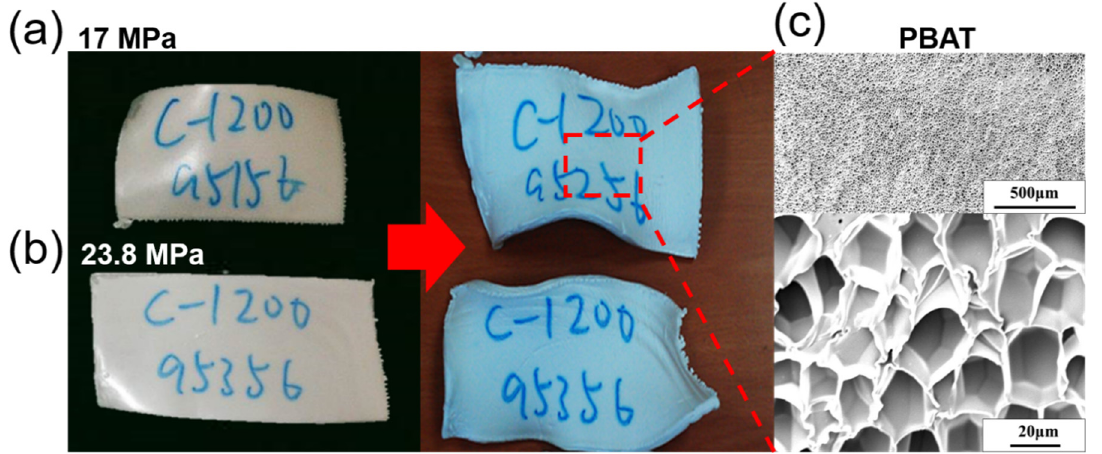
Figure 4. The changes in the foam impregnated with CO 2 at the foaming temperature of 95 °C and the foaming pressure ( a ) 17 MP and ( b ) 23.8 MPa. ( c ) The SEM image of the PBAT foams was magnified by 50 times and 1000 times, respectively, at a foaming temperature of 95 °C and a foaming pressure of 17 MPa.